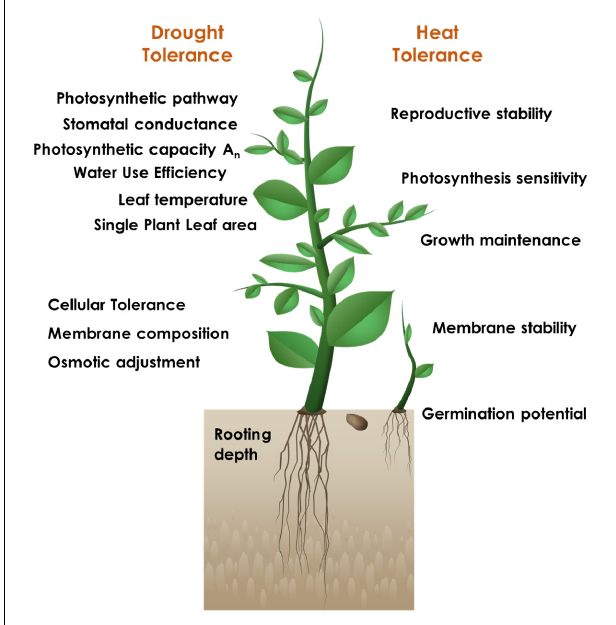
FIGURE 1 | Physiological trait-based screening for identification of drought and heat stress tolerant sources.